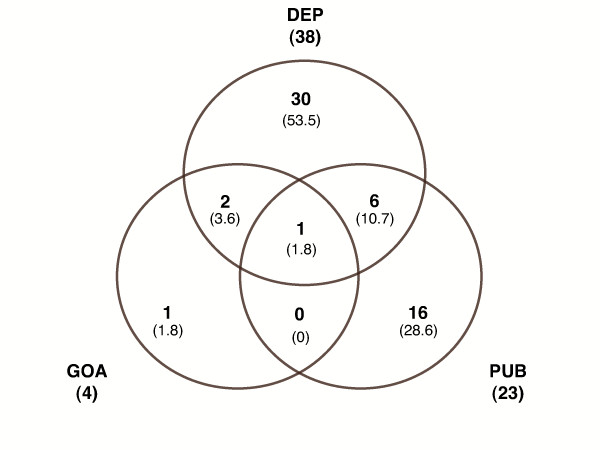
Venn diagram for cdc2. Number of GO Process terms in each category (overall percentage in brackets). Evidence annotation (GOA), Literature annotation (PUB) and Associative relations (DEP).